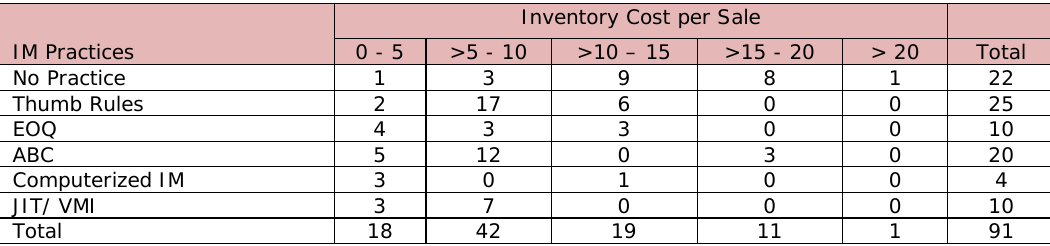
Table 5. “Inventory Practices and Inventory Cost per Sale”.